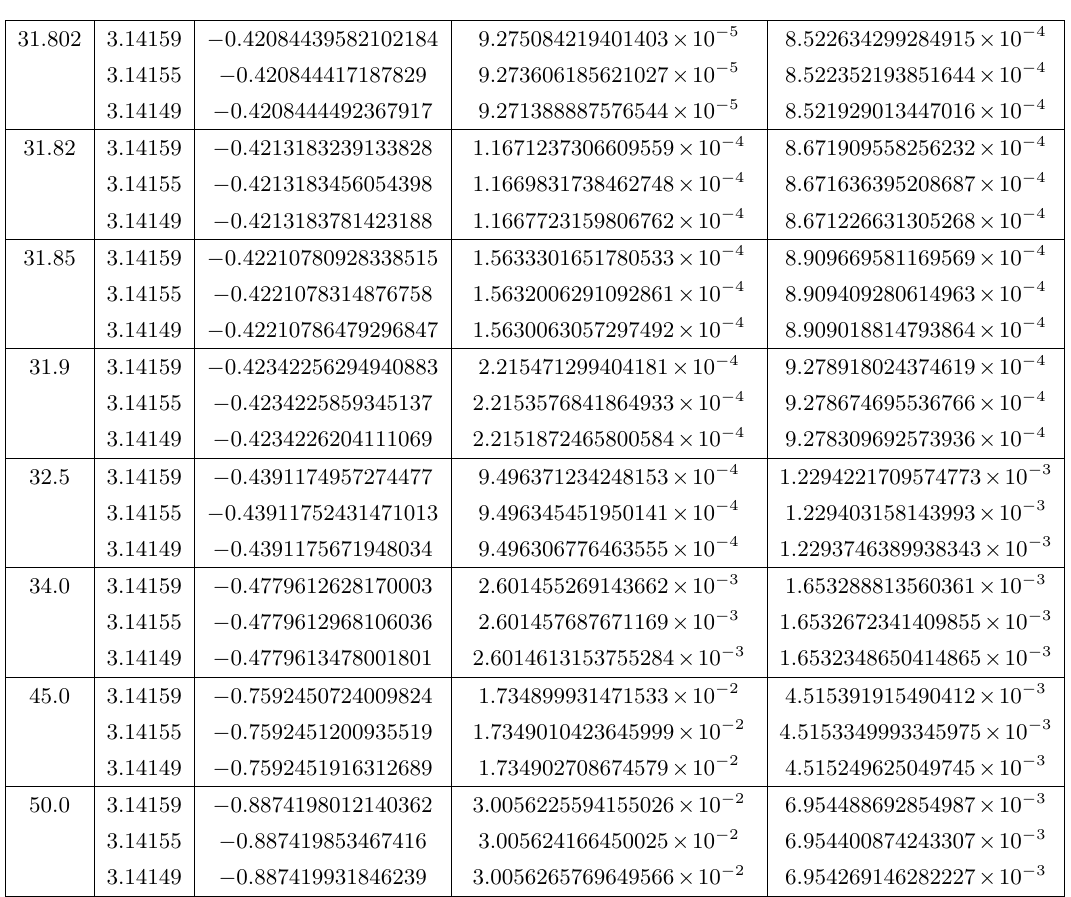
Table 5. N = 50 , partial phase at finite θ